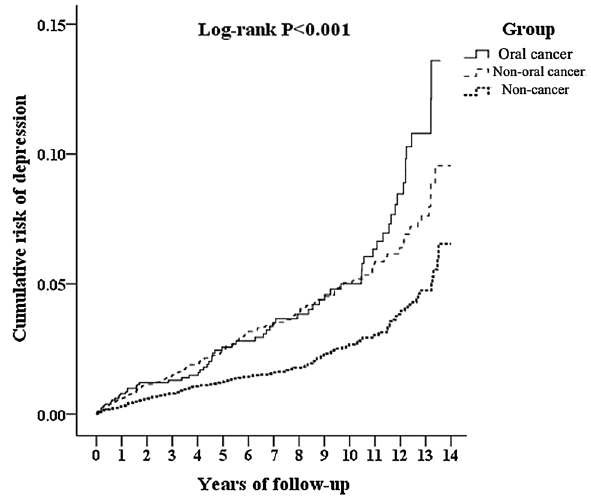
Figure 2. Kaplan–Meier for cumulative risk of depression among patients aged 20 and over stratified by study group with log-rank